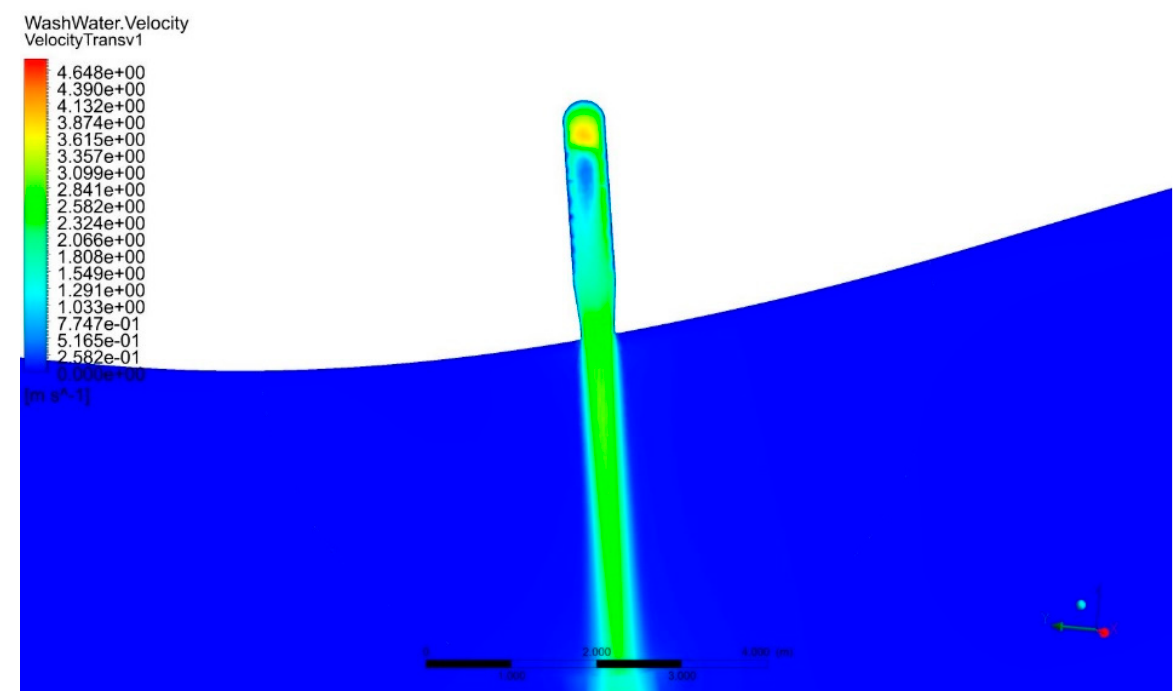
Figure 11. Velocity variation—pipe transversal section.